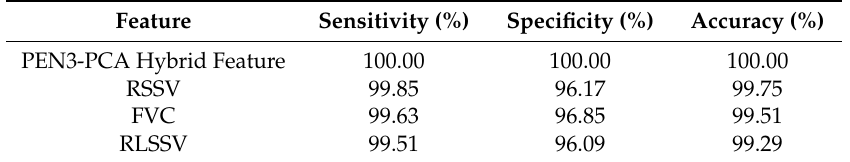
Table 10. Average PNN classification results comparison between the best features for the PEN3 dataset.